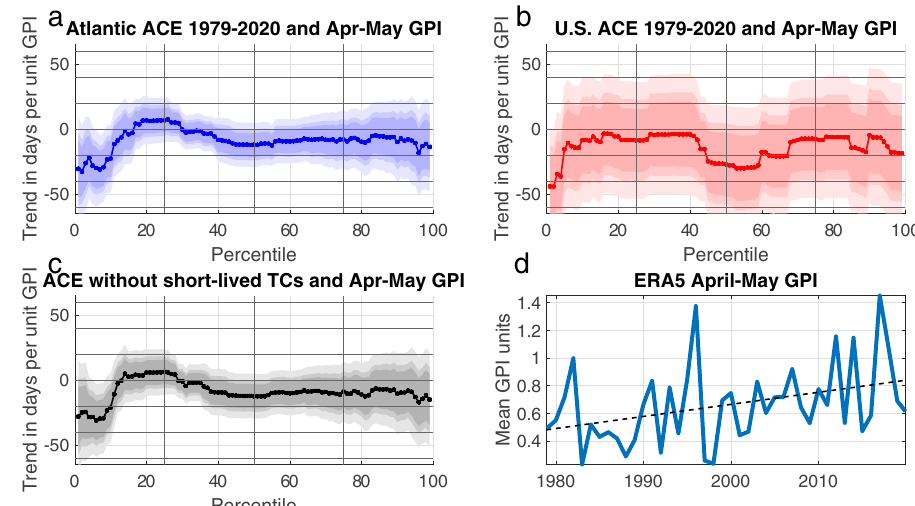
Fig. 2 Quantile regressions of tropical cyclone (TC) activity with western Atlantic basin spring Genesis Potential Index (GPI) values. Trends of 1st – 99th percentile threshold date between 1979 – 2020 in days per April – May mean unit of GPI 23 over 10 – 36°N, 100 – 70°W for ( a ) Atlantic Accumulated Cyclone Energy (ACE), ( b ) ACE over the continental United States (USACE), and ( c ) Atlantic ACE excluding short-lived TCs. d Mean values of April-May GPI from ERA5 reanalysis over 10 – 36°N, 100 – 70°W for 1979 – 2020, with the linear trend displayed with a dashed line. Light, medium, and dark shading indicates the 99%, 95%, and 90% con fi dence intervals, as in Fig. 1.